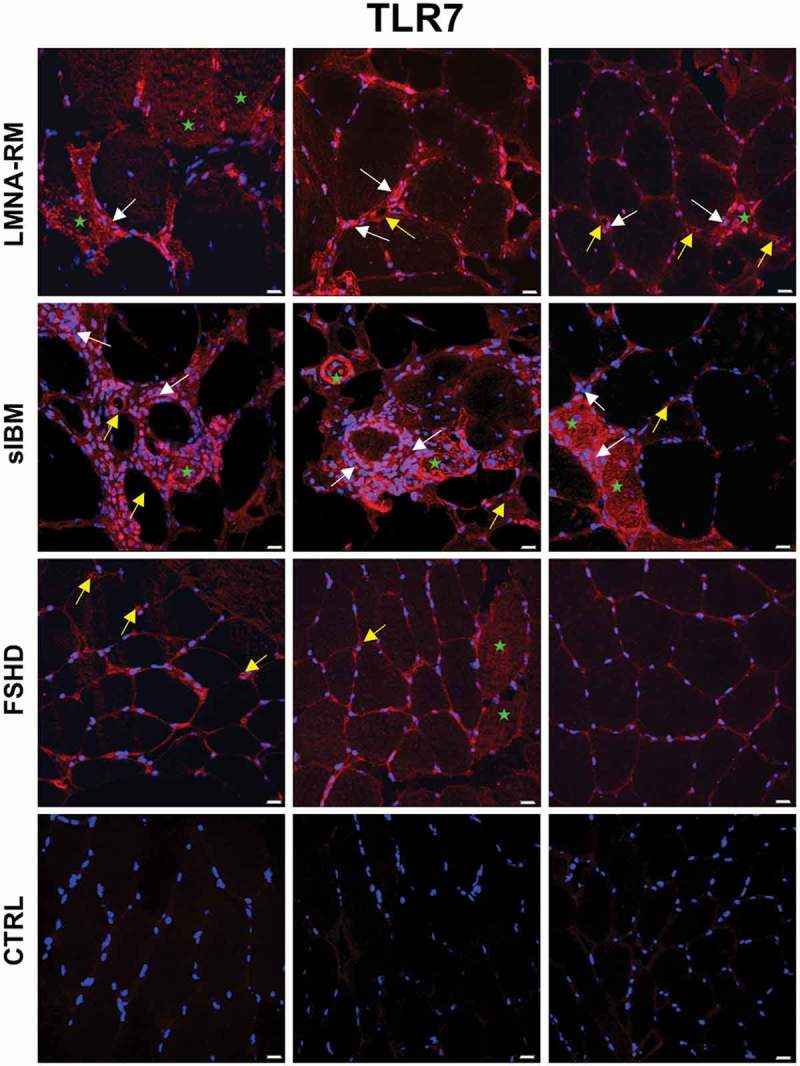
Immunofluorescence staining of TLR7 in LMNA-RM, sIBM, FSHD patient and non-myopathic control (CTRL) muscles. In LMNA-RM TLR7 was highly expressed in the endomysial space, on capillaries and small blood vessels (yellow arrows), at the level of discernable inflammatory cells (white arrows), and occasionally on the sarcolemma or within some muscle fibers (green stars). In sIBM TLR7 localized mainly at the level of inflammatory infiltrates (white arrows) and on degenerating myofibers (green stars) surrounded/invaded by immune infiltrates or characterized by sarcoplasmic inclusions. FSHD showed a TLR7 positive staining in the endomysium and rarely within some muscle fibers (green stars). A weak or negative staining was observed in control muscle tissues. Original magnification, X40; bar 20 μm.